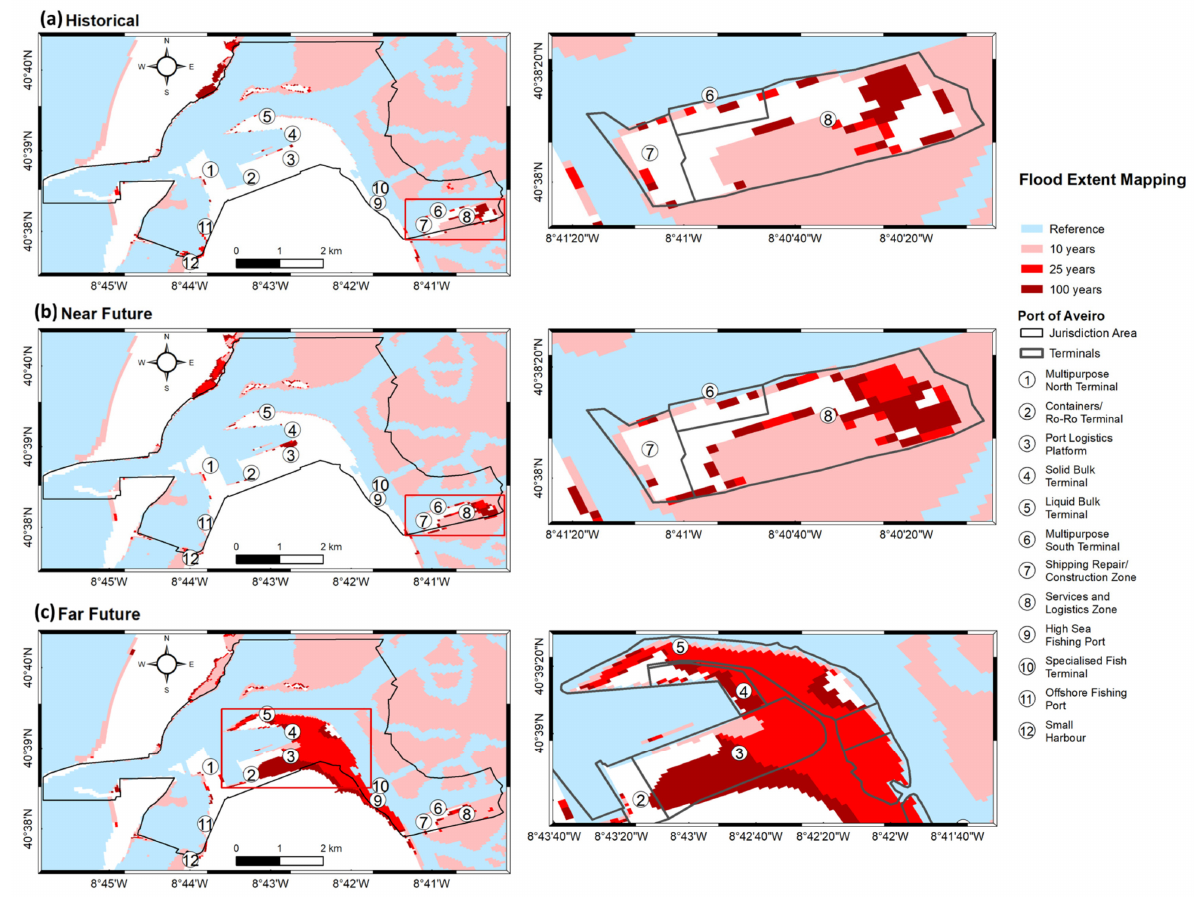
Figure 10. Flood extent mapping of the Aveiro port’s terminals (numbers 1–12) located along the lagoon margins. Reference scenario under present climate and 10-, 25- and 100-year return periods are determined for the ( a ) historical (1979–2005), ( b ) near future (2026–2045) and ( c ) far future (2081–2100) climate periods. The data was retrieved from [34].